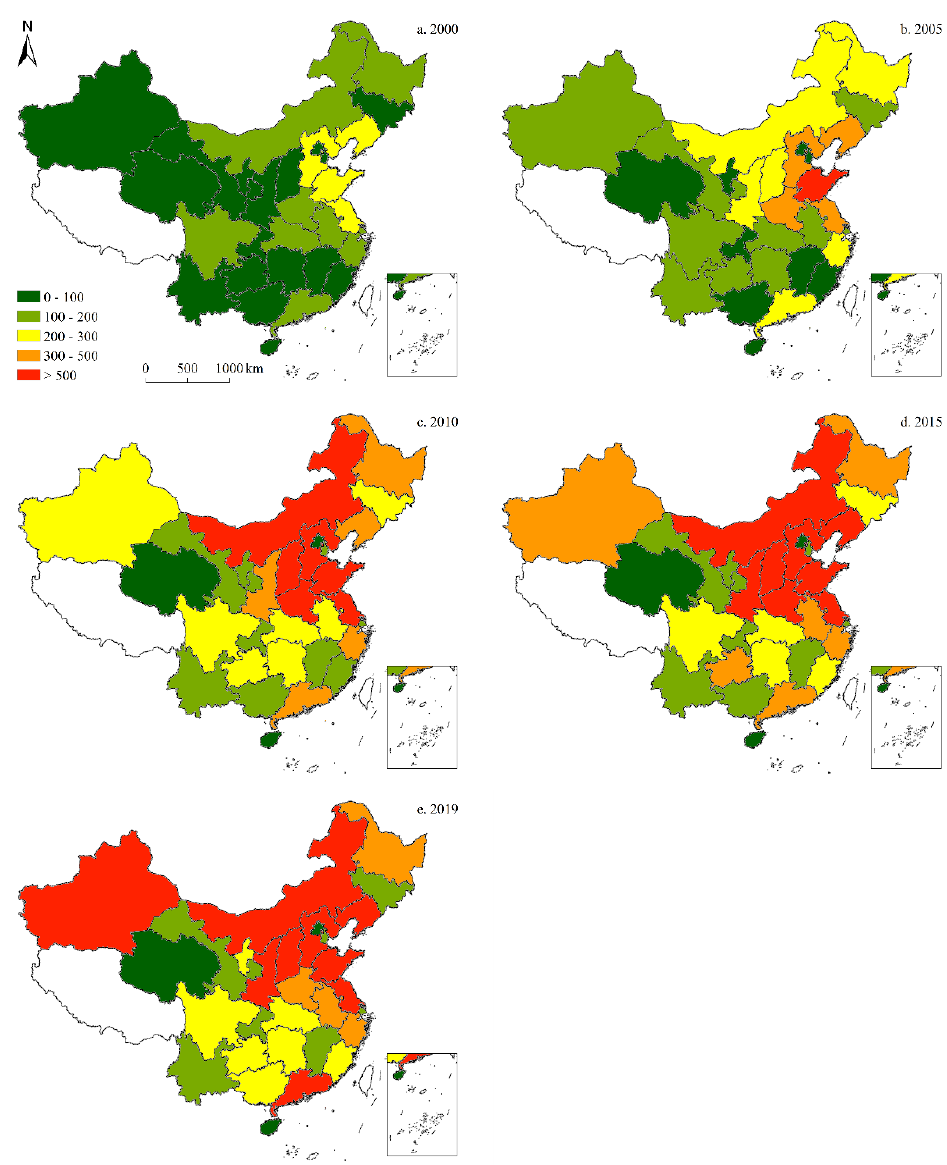
Figure 7. Spatiotemporal distribution of provincial-level total CO 2 emissions (in million tons) in China since 2000.